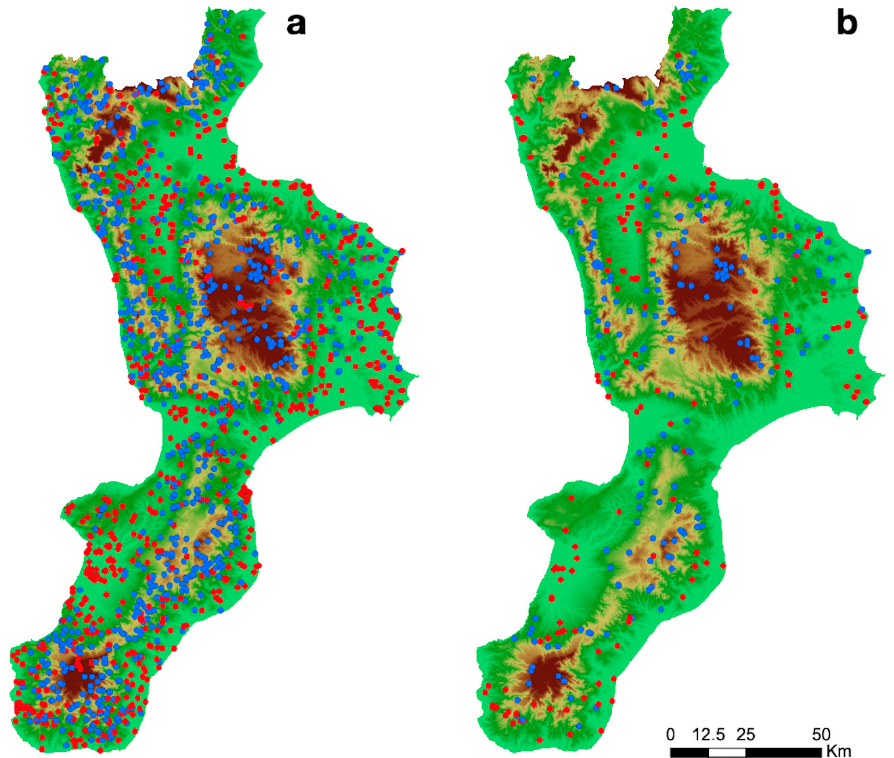
Figure 4. Georeferenced distribution: ( a ) phytotoponyms relating to forest species, ( b ) toponyms referring generically to the forest without specifying the species, and agreement with current forest vegetation. Blue, agreement with current forest vegetation, red, no agreement.